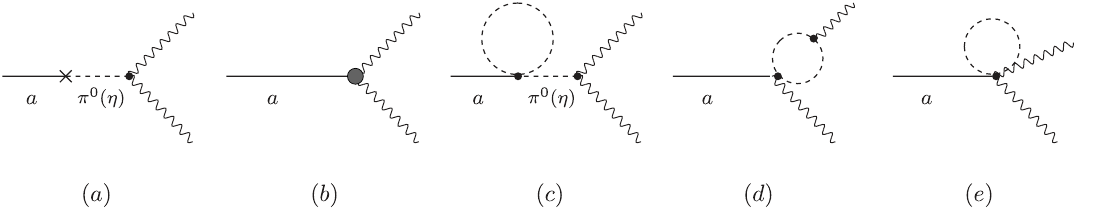
(cid:0) (cid:1) p 6 . Here